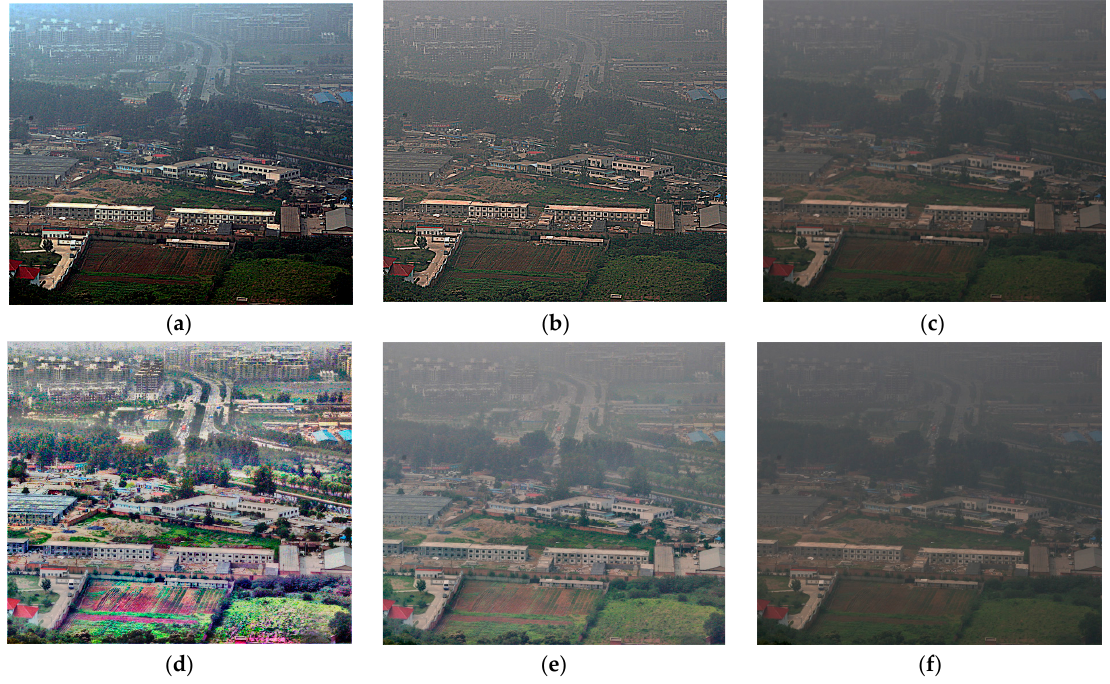
Figure 6. ( a ) PA, ( b ) without GOCS, ( c ) using high-boost filter setting, ( d ) AMEF ( c = 0.1), ( e ) AMEF ( c = 0.01), and ( f ) AMEF without CLAHE.